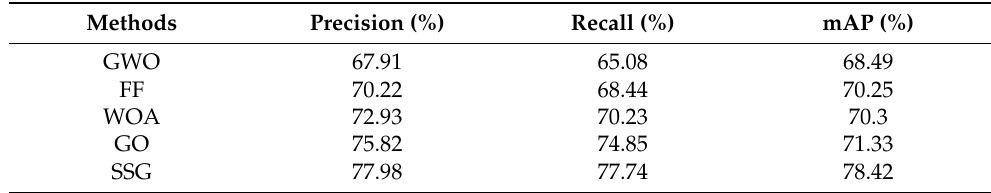
Table 4. Feature selection techniques performance on DIOR dataset.